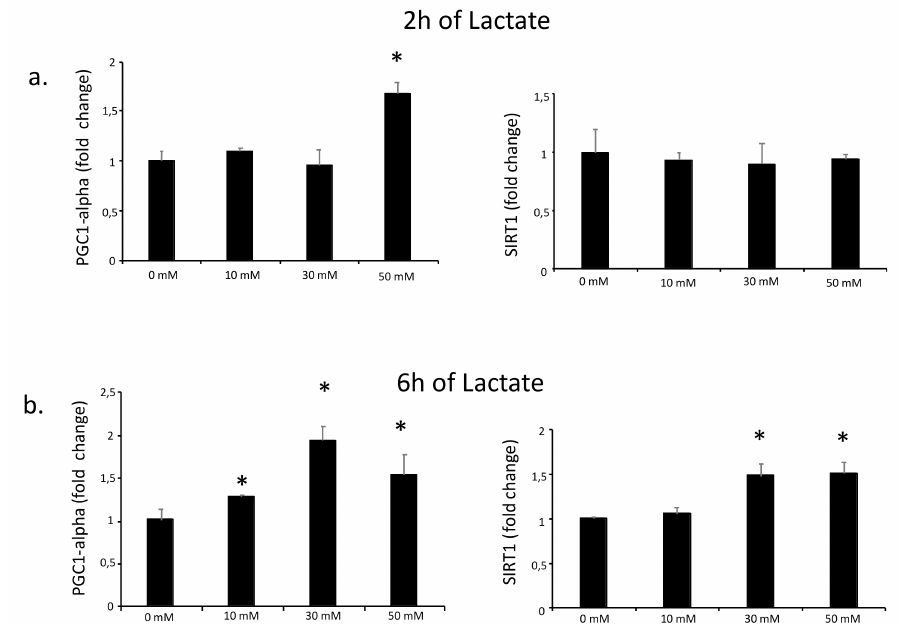
Figure 1. qPCR analysis of PGC1-alpha and SIRT1 expression in C2C12 myotubes cultured with L-lactate. C2C12 myotubes were cultured for 2 ( a ) and 6 h ( b ) with L-lactate at di ff erent concentrations (0, 10, 30, and 50 mM). In the time between lactate culture and sample collection (one hour), cells were cultured with DM. Error bars show standard deviations. * p < 0.05 from 0 mM. All the experiments were performed three independent times with three replicates each